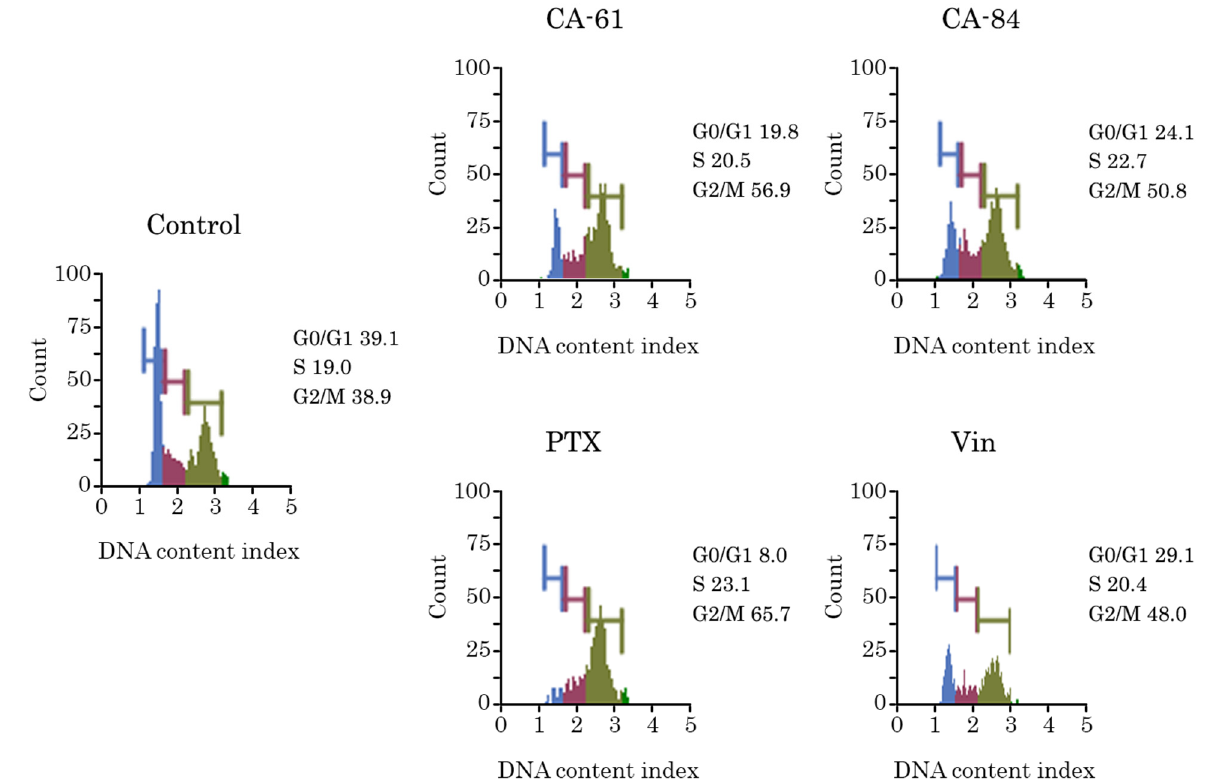
Figure 9. Cell cycle profile of HCC1806 breast cancer cells treated with CA-61, 84, Paclitaxel (PTX), or Vinblastine (Vin). Representative histograms illustrating the increased numbers of cells in the G2/M phase after the treatment with CA-61 and -84 for 9 h. PTX and Vin were used for the positive controls. Table 3. Quantitative analysis of the cell-cycle distribution in HCC1806 breast cancer cells as meas- ured by the flow cytometry described in Figure 7. Normally, distributed data are presented as mean ± standard deviation, non-normally distributed data are shown as median (interquartile range); * p < 0.05, ** p < 0.01.